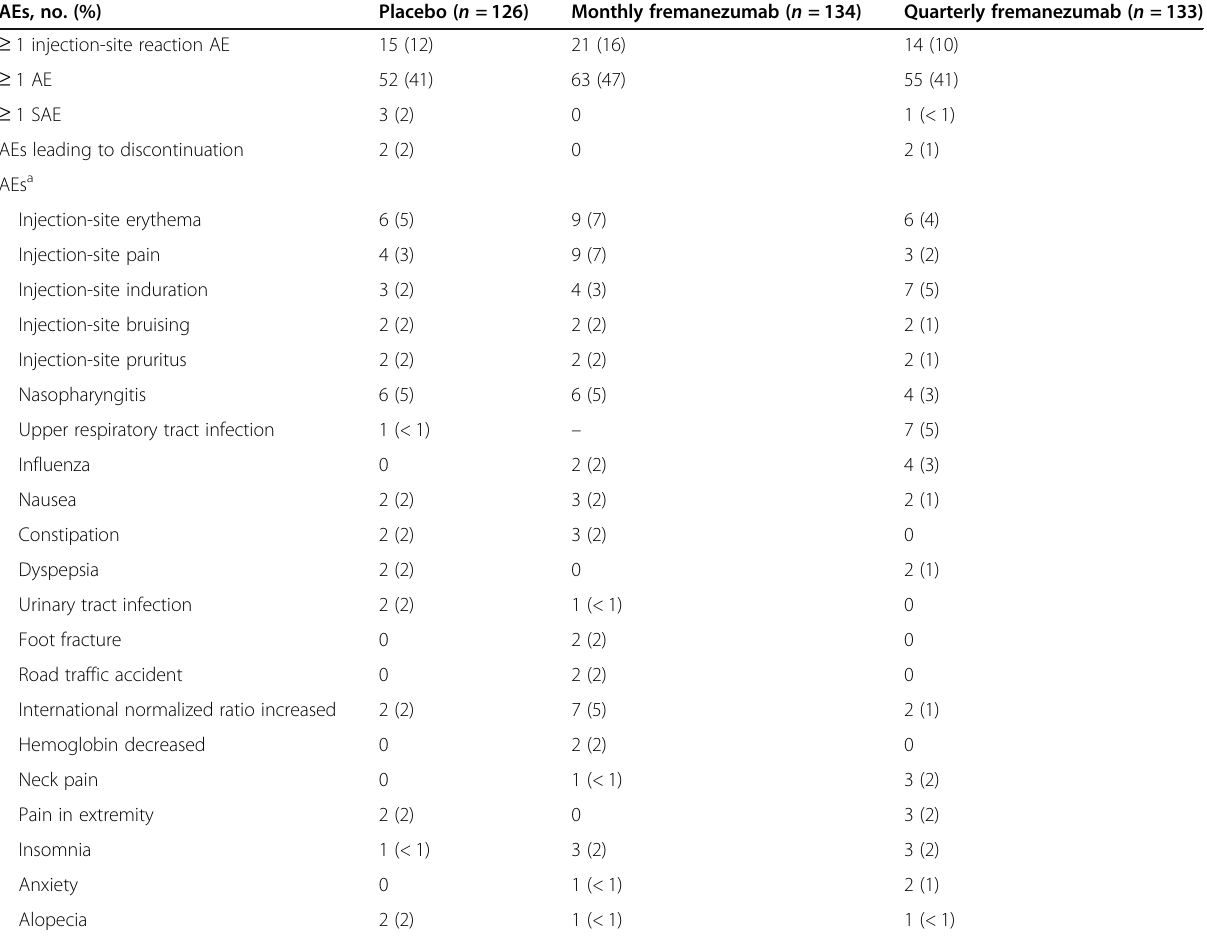
Table 3 Tolerability in the 3 Top-recruiting Countries (Czech Republic, United States, and Finland) AEs, no.